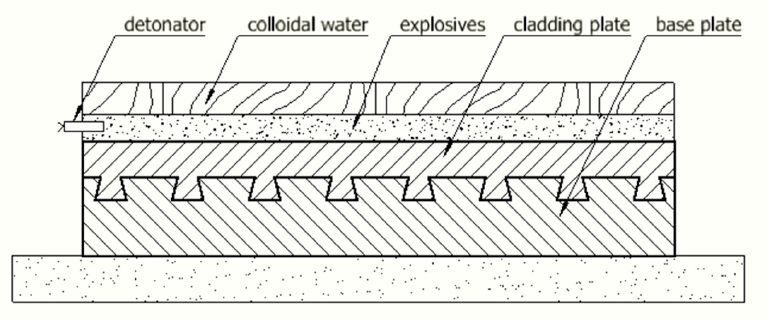
Figure 1. Honeycomb aluminum structure explosive.